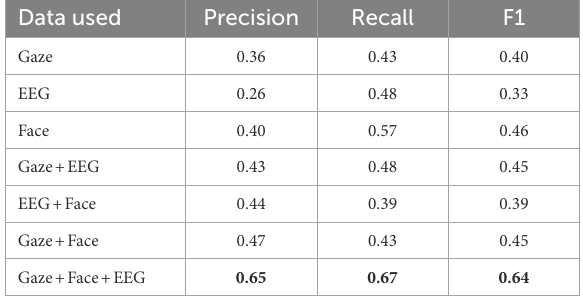
TABLE 2 Cognitive engagement prediction